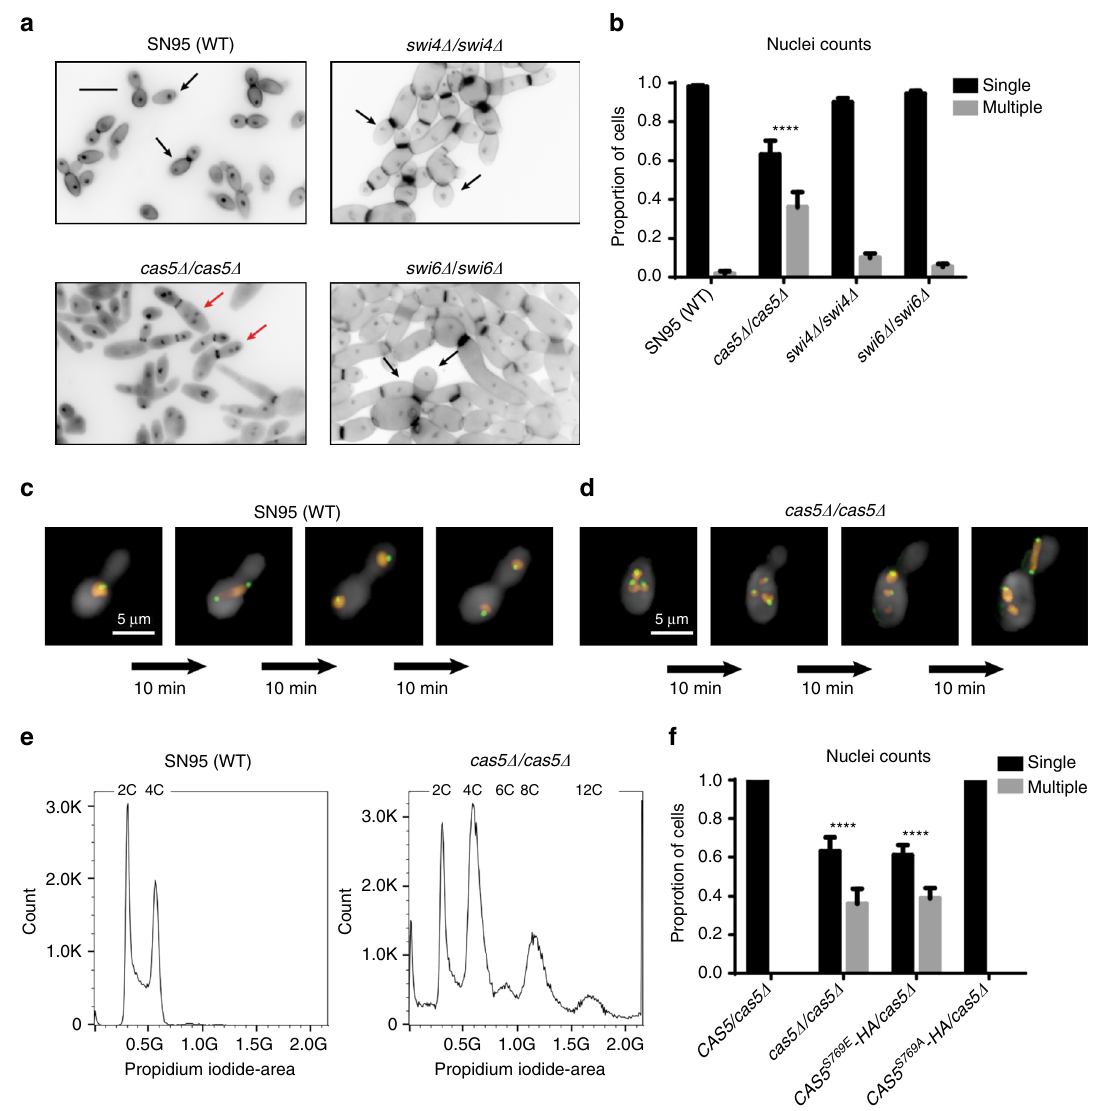
Fig. 9 Cas5 regulates nuclear division largely independent of Swi4 and Swi6. a Nuclei were stained with DAPI and chitin was stained using calco fl uor white. For each image, 12 Z-stack slices were taken at 0.3 μ m each. Black arrows highlight cells with a single nucleus. Red arrows highlight cells with a multinucleated phenotype. b Mutants lacking Cas5 exhibit severe cell cycle defect. The histogram represents the average number of nuclei per cell in three biological replicates. The number of nuclei counted in each experiment was at least 120 cells for each strain. The nuclei counts for each strain were averaged and error bars represent standard deviation (s.d.) from the mean of biological duplicates. Nuclei counts for each strain were compared to the wildtype using one-way ANOVA in GraphPad Prism (**** P < 0.0001). c , d Mitotic spindles are aligned along the mother – bud axis during cell division in wild-type cells ( c ) and misaligned in a mutant lacking Cas5 ( d ). DNA was monitored by RFP-tagged Hhf1, and mitotic spindle was monitored by GFP- tagged Dad2 using time-lapse fl uorescence microscopy. e Cas5 is required for maintaining normal DNA content throughout the cell cycle. Cellular DNA content was measured by propidium iodide and fl ow cytometry of the wild-type diploid and the cas5 Δ /cas5 Δ mutant strain. The wild-type diploid has the standard G1 and G2 cell cycle peaks representing 2C and 4C DNA levels. The cas5 Δ /cas5 Δ mutant population, in addition to the same 2C and 4C DNA levels, contained a large subpopulation of cells with DNA levels at 6C, 8C, and 12C. These DNA levels represent tetraploid (4N) and hexaploid (6N) cells. f Activation of Cas5 by dephosphorylation is required for proper cell cycle progression. The histogram represents the average number of nuclei per cell in three biological replicates. The number of nuclei counted was at least 120 cells for each strain. The nuclei counts for each strain were averaged and error bars represent s.d. from the mean of biological duplicates. Nuclei counts for each strain were compared to that of the wildtype using one-way ANOVA in GraphPad Prism (**** P <